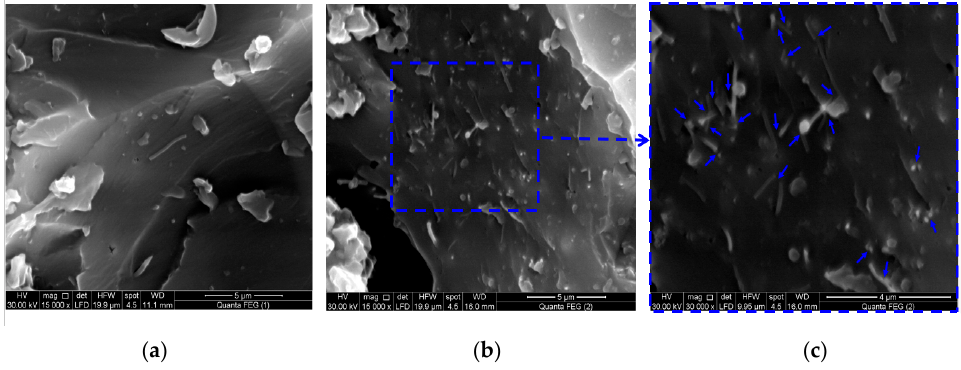
Figure 9. FESEM images of CNFs in the epoxy matrix; ( a ) 0.5 wt %; ( b ) 2.0 wt %; and ( c ) a close view of 2.0 wt % CNFS shows the formation of conductive network inside epoxy.